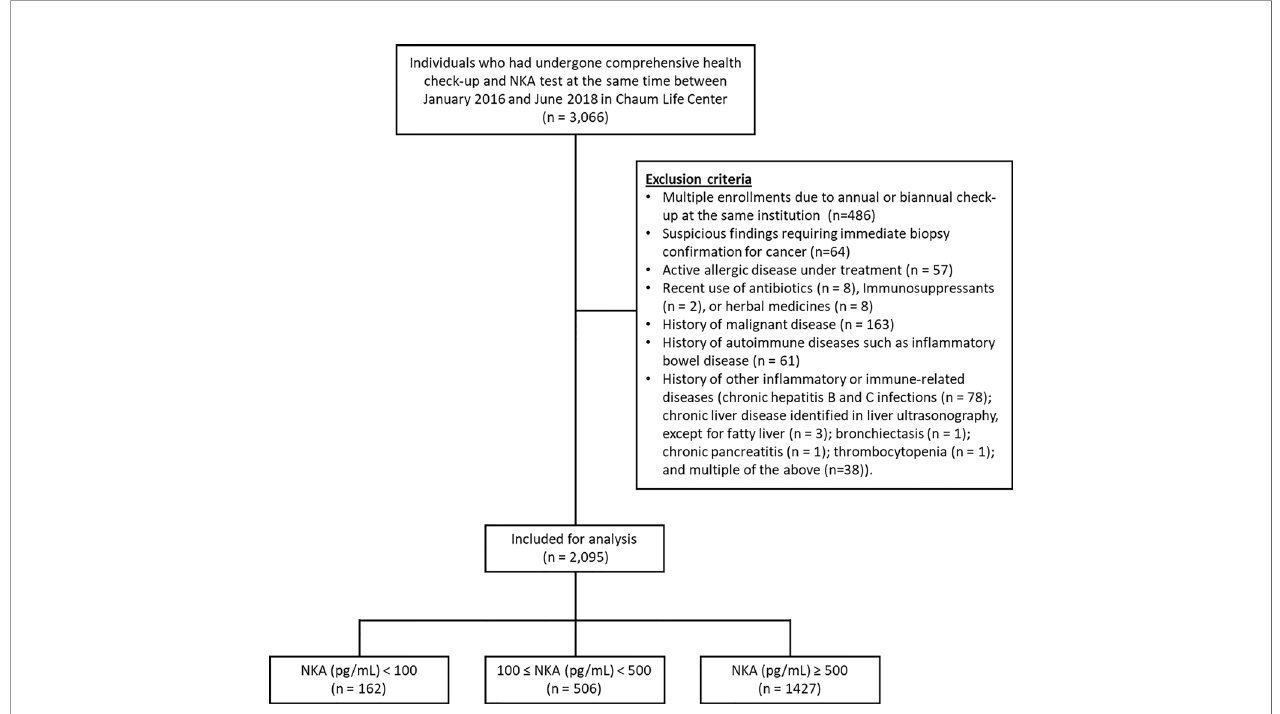
FIGURE 1 | Participant fl ow chart. NKA, natural killer cell